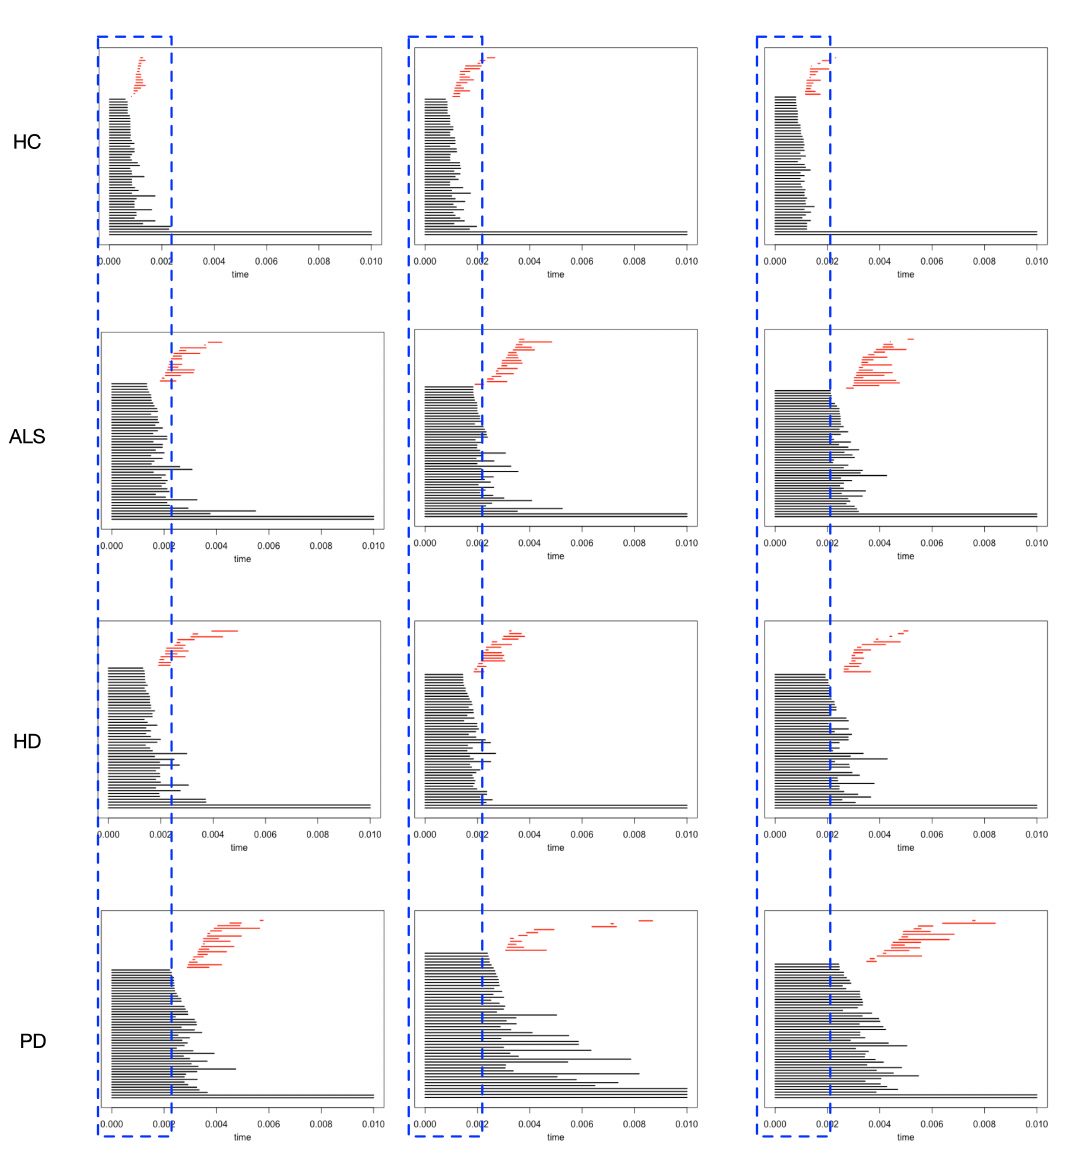
Figure 8. An illustration for the barcodes for each group. First row for the HC group; second row for ALS group; third row for the HD group; fourth row for the PD group. With the blue box-based indicator, we can see that the red bars’ positions are different in the HC group (first row) to the rest, i.e., the 1-dimensional homologies’ durations (appear earlier and vanish earlier for the red bars) in the HC group are different from abnormal